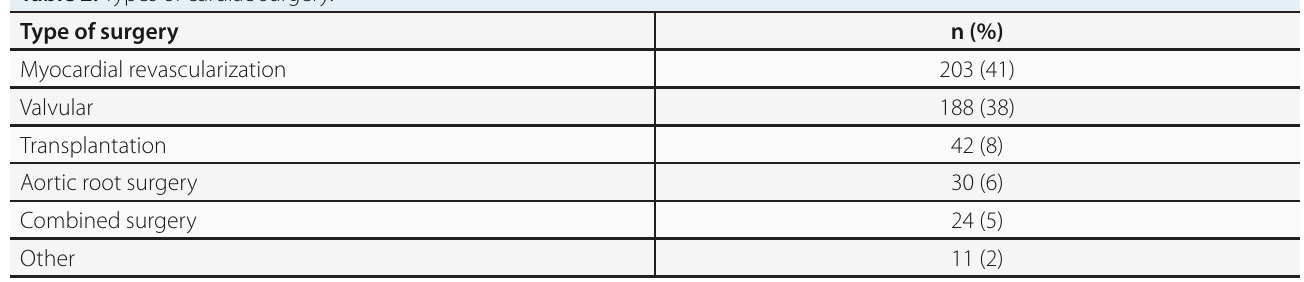
Table 2. Types of cardiac surgery.